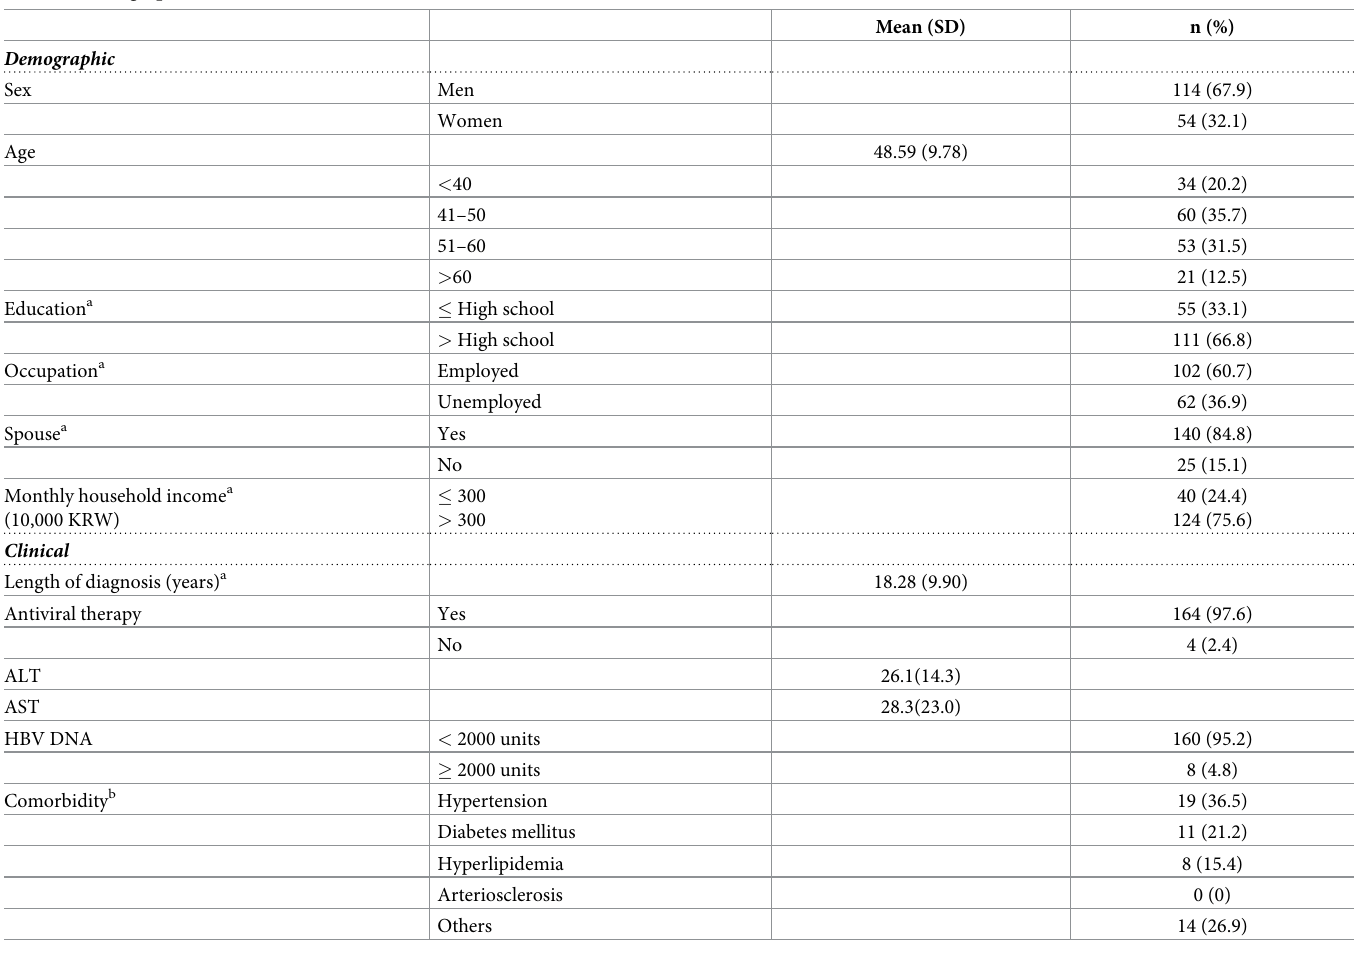
Table 1. Demographic and clinical characteristics (N =